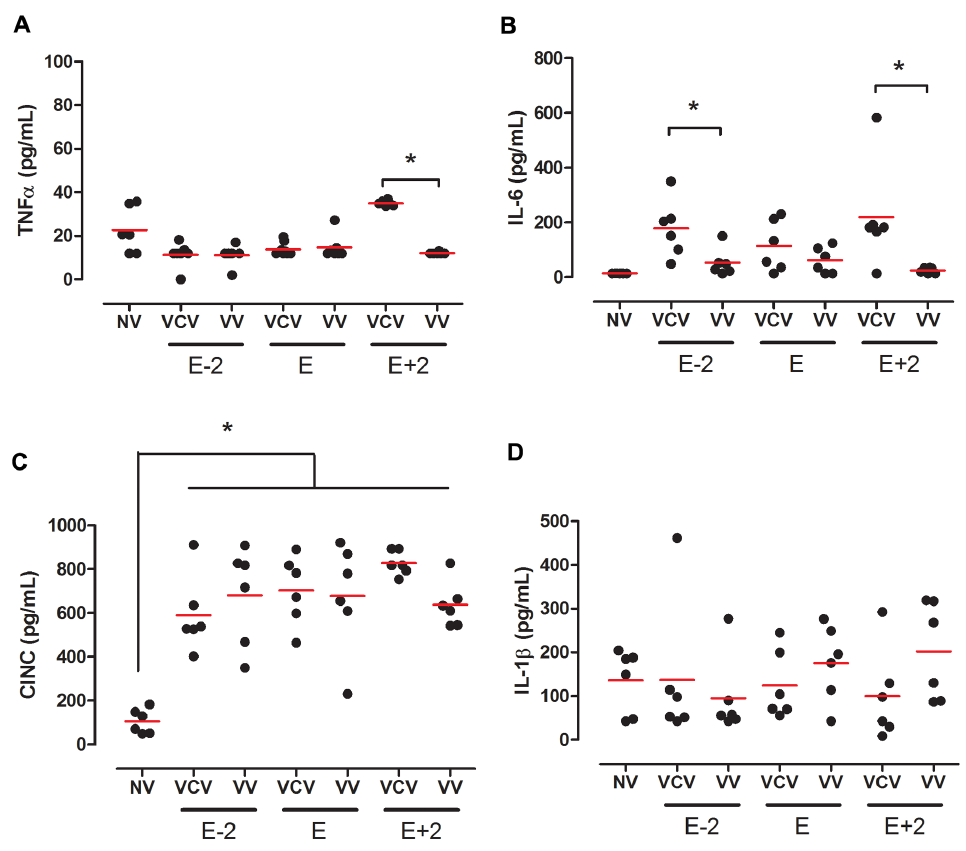
Figure 6. Lung cytokines. Lung tissue concentration of TNF- a (A), IL-6 (B), CINC-1(C) and IL-1 b (D) in the groups: VCV_E (volume-controlled mode and PEEP minErs ; n=6), VCV_E + 2 (volume-controlled mode and PEEP minErs plus 2 cmH 2 O; n=6), VCV_E-2 (volume-controlled mode and PEEP minErs minus 2 cmH 2 O; n=6), VV_E (variable ventilation and PEEP minErs ; n=6), VV_E + 2 (variable ventilation and PEEP minErs plus 2 cmH 2 O; n=5), VV_E-2 (variable ventilation and PEEP minErs minus 2 cmH 2 O; n=6). Red lines represent mean values. Ventilatory mode and PEEP effects were tested with two- way ANOVA followed by Tukey post hoc. T-test was used to detect differences between ventilated and non-ventilated groups and then correction by multiple comparison. Statistical significance was accepted at p , 0.05. *p , 0.05.